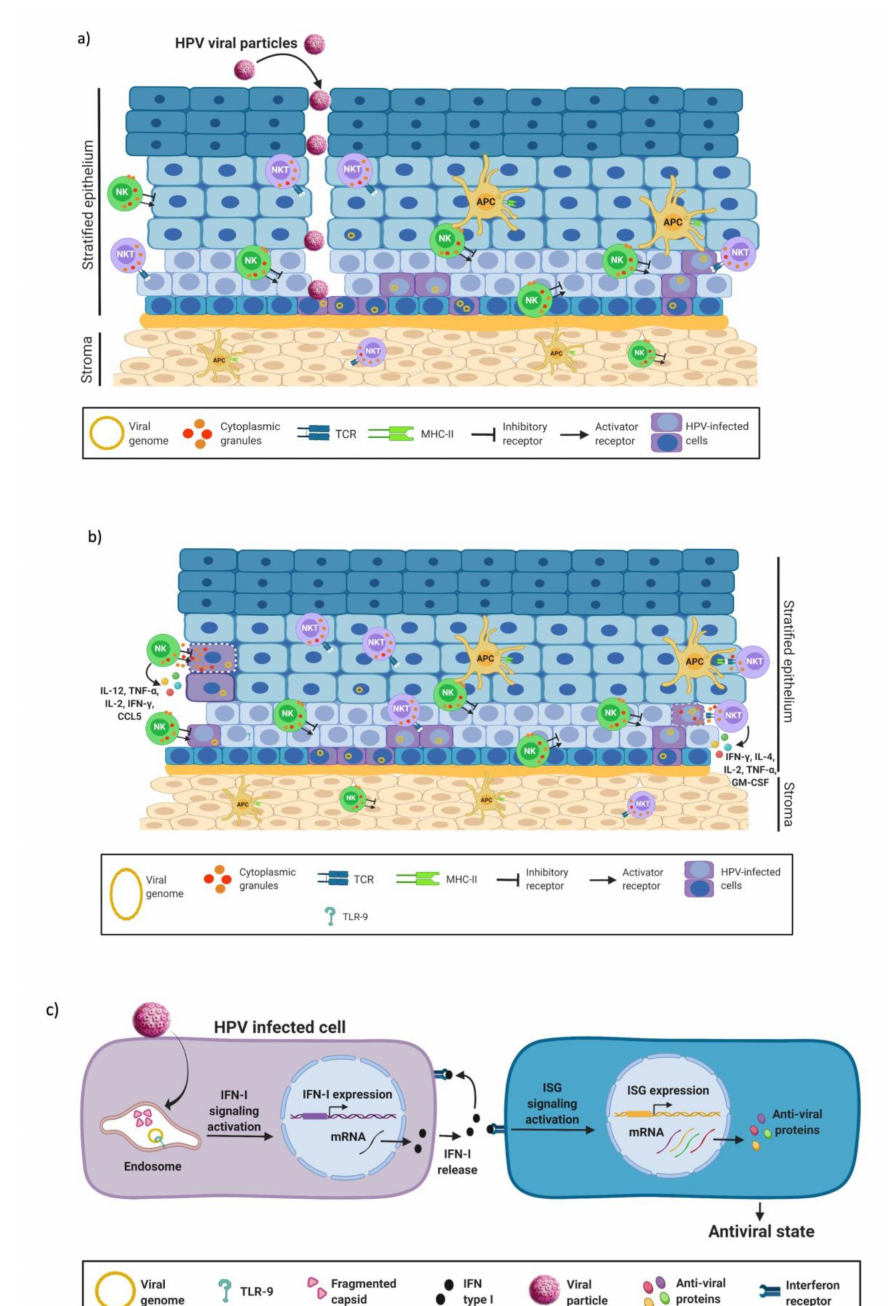
Figure 1. Innate immune response against HPV. ( a ) The HPV viral particle infects the basal cells, gaining access through microtrauma. Several elements of the immune response are highly active throughout the different layers of the epithelium including APC, NK and NKT, which are respon- sible for recognizing and clearing infectious agents. ( b ) Infected cells are recognized by NK cells through KIR receptors, inducing their elimination by releasing their cytoplasmic granules containing granzyme, perforin and cytokines. Moreover, NKT cells control infection by other mechanisms. For example, the CD1d receptor activates NKT cells to produce apoptosis of the infected cell and cytokine release that will help activate the adaptive immune response. NKT cells act as a bridge between innate and adaptive immunity. ( c ) Once the cell is infected by HPV, the TLR-9 receptor detects the viral genome in the cytoplasm. Then, TLR-9 activates IFN-I production and ISG expression promoting an antiviral effect. Figure created using